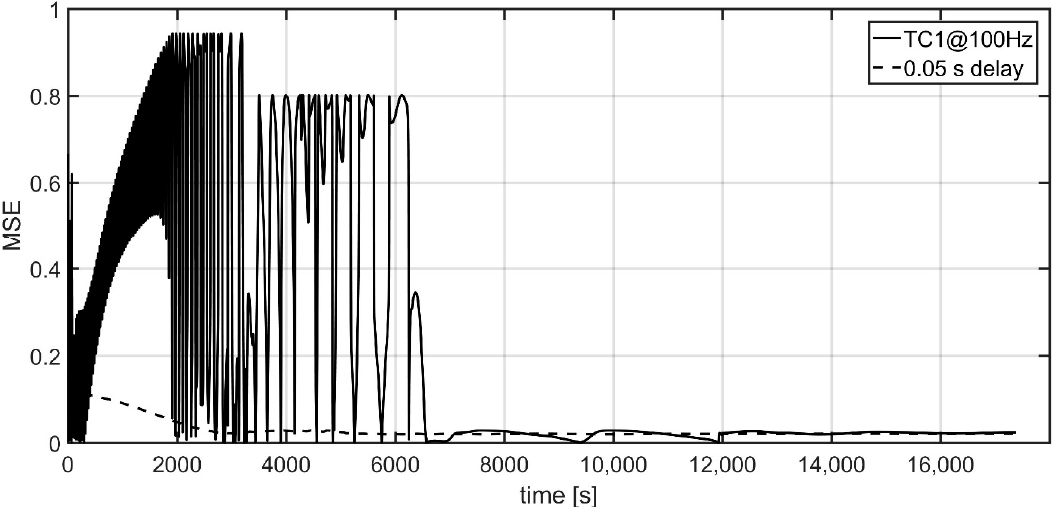
Figure 11. MSE calculated on the estimated A k and on the actual A with 5 × 10 − 2 s delay for Test Case 1 at 100 Hz.